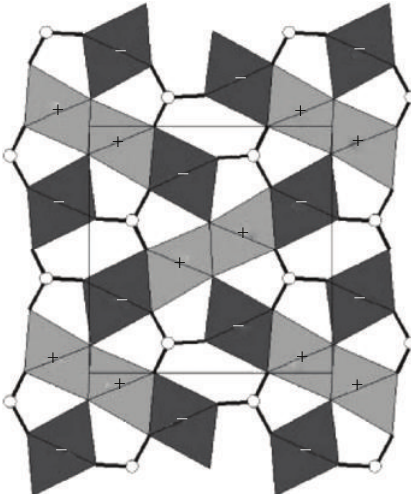
Figure 13: The Fe 2 OBO 3 structure projected on (100) plane ( b vertical, c horizontal). Two structurally distinct Fe(1)O octahedra shown by light and dark sharing, respectively. Fe(2)O 6 Plus and minus signs indicate the relative orientation of the moments within each Fe(1) and Fe(2) chains in the magnetically ordered